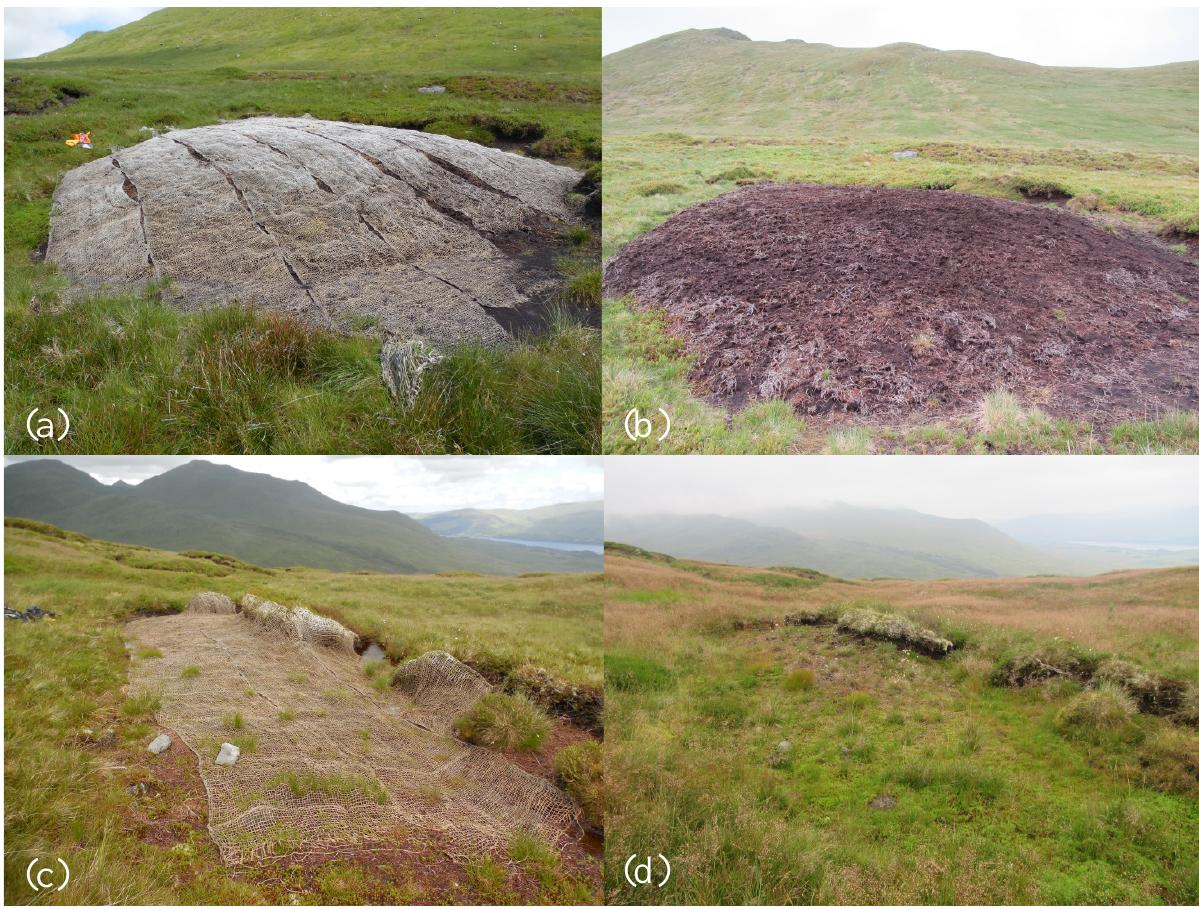
Figure 5. A photographic comparison of the revegetation and netting damage sustained by two sites applied with thick heather brash and Geojute netting. (a) Coire Odhar (grazed) site just after treatment, (b) the same CO site four years later; (c) Meall nan Tarmachan (ungrazed) site one year after treatment (d) the same MT site three years